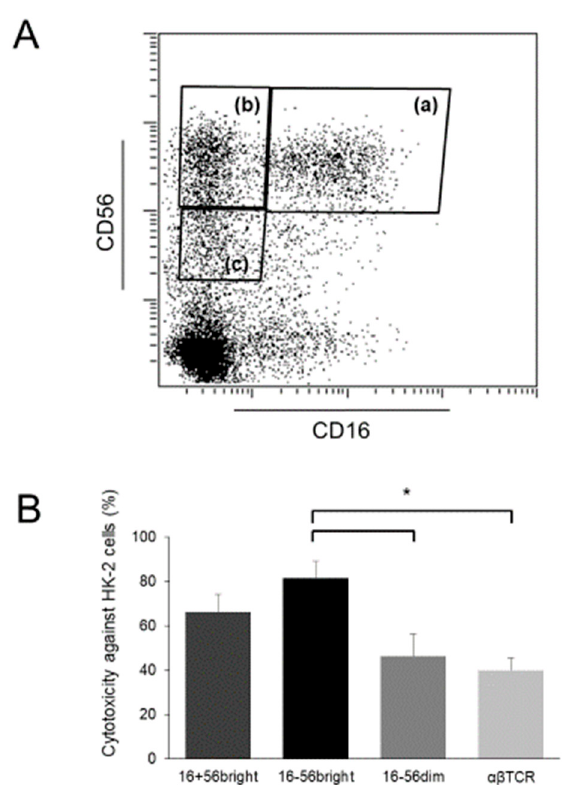
Figure 2. Proliferation of CD56 bright cells with strong cytotoxicity against renal tubular epithelial cells after cytokine stimulation. ( A ) Flow cytometric profiles of NK cell subsets. Human peripheral blood mononuclear cells were isolated and cultured for 14 days under stimulation with IL-2, IL-12, and IL-15. Thereafter, they were sorted into CD16 + CD56 bright cells (a), CD16 − CD56 bright cells (b), CD16 − CD56 dim cells (c), and αβ TCR + cells using a cell sorter; ( B ) Cytotoxic activity of cells analyzed using the calcein-acetyoxymethyl cytotoxicity assay. The sorted cells in ( A ) were cultured again with the same procedure overnight to recover their function from the damage by sorting. These cells and human proximal tubular epithelial HK-2 cells (ATCC, Manassas, VA, USA) were used as effector cells and target cells, respectively. Effector-to-target ratios were 5:1. Data are presented as arbitrary units ± standard of error of the mean ( n = 3 in each group); * p < 0.05.